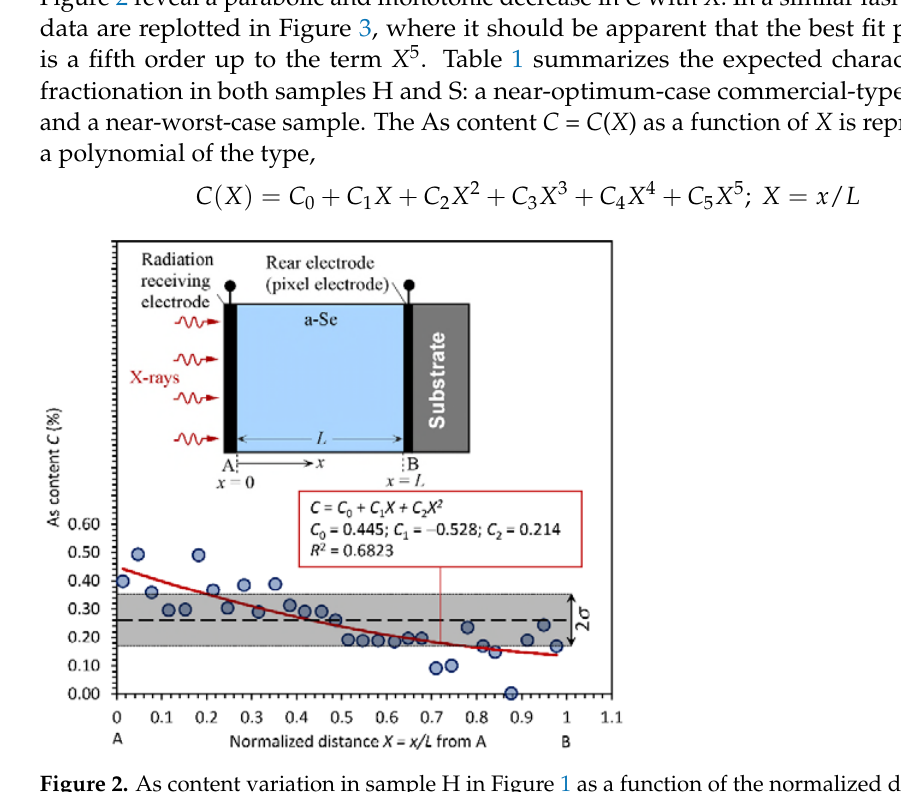
Figure 2. As content variation in sample H in Figure 1 as a function of the normalized distance from the radiation ‐ receiving electrode A. The red curve is the best second ‐ order polynomial fit. The inset shows the device geometry. (Data extracted from [5], normalized and reanalyzed to plot the As content from the radiation ‐ receiving side, A, toward the substrate, B).